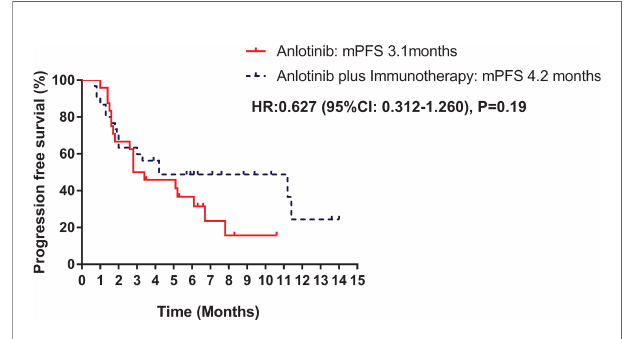
FIGURE 3 | Kaplan – Meier curves of PFS between anlotinib arm and anlotinib plus immunotherapy arm.